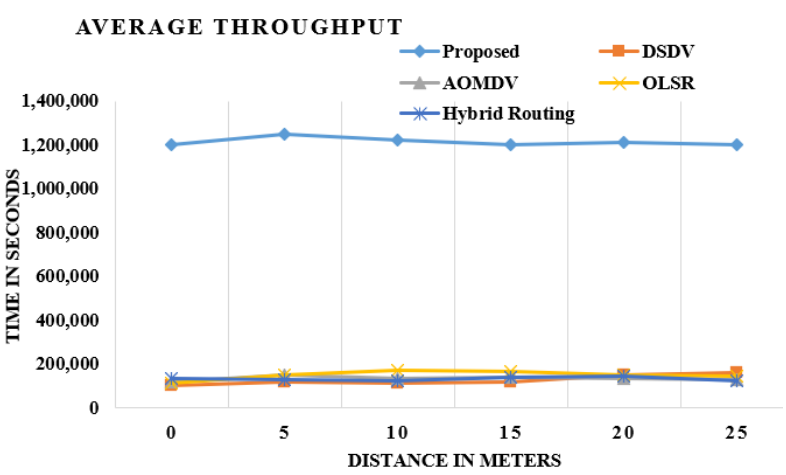
Figure 8. Comparison of existing and proposed techniques in average